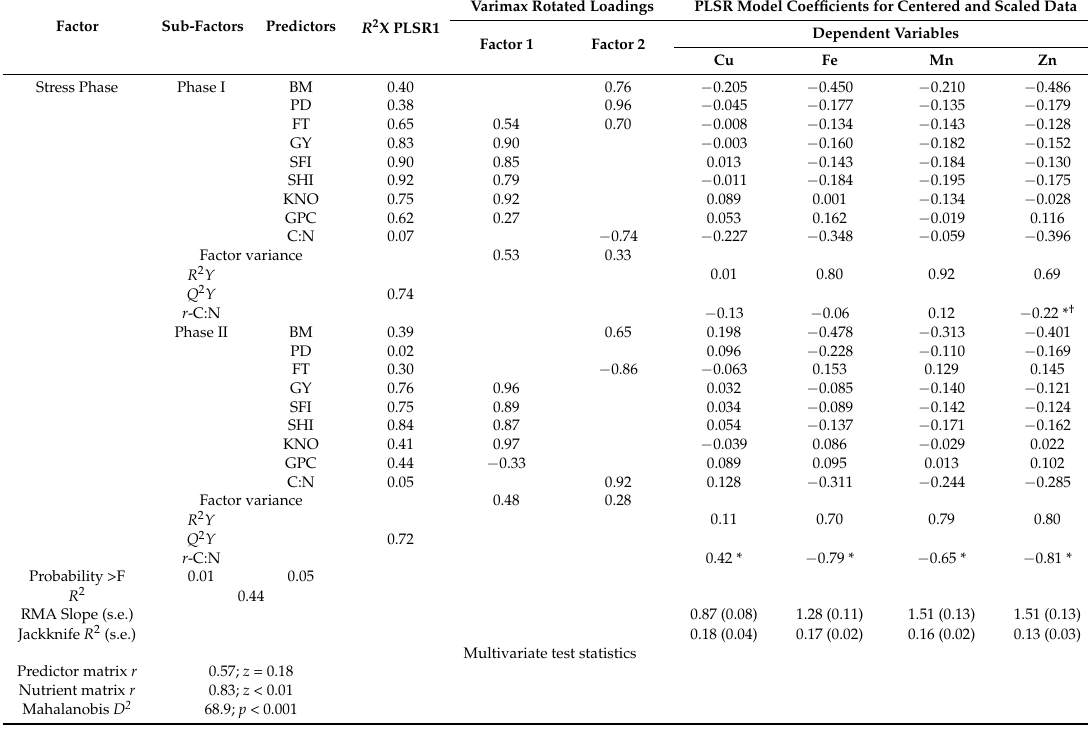
Table 4. Multiple comparisons between two abiotic stress phases imposed on T. aestivum and T. durum , each of three years, using partial least squares regression (PLSR), factor analyses, prediction of micronutrients as functions of phenotypic plasticities, multivariate distances, and matrix correlations between predictors and between predicted